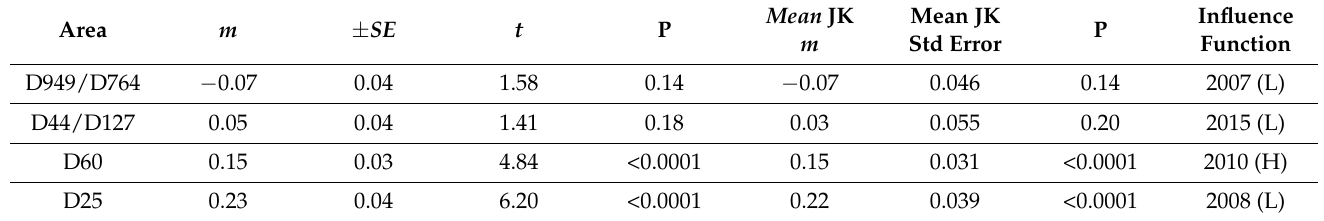
Table 2. Regression coefficients ( m ) relating annual mortalities between 2005 and 2019 along